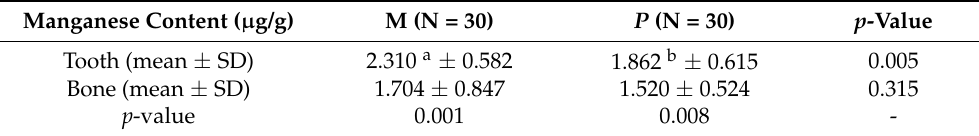
Table 24. Manganese content in tested samples taken from patients differing in place of residence.